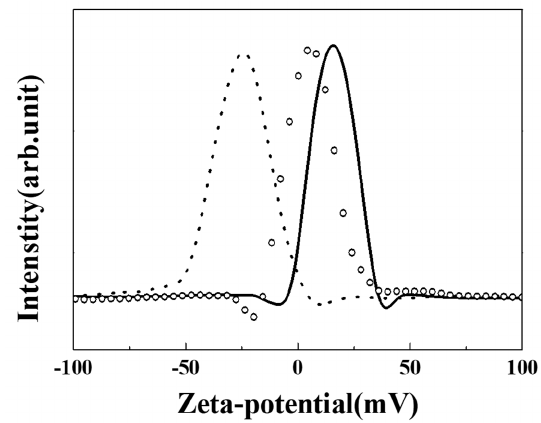
Figure 4. Zeta-potential graphs of: MgFe–LDH (layered double hydroxide)–solid line, Zingiber officinale extract (ZOE)–dashed line, and ZOE–LDH hybrid–open circles.